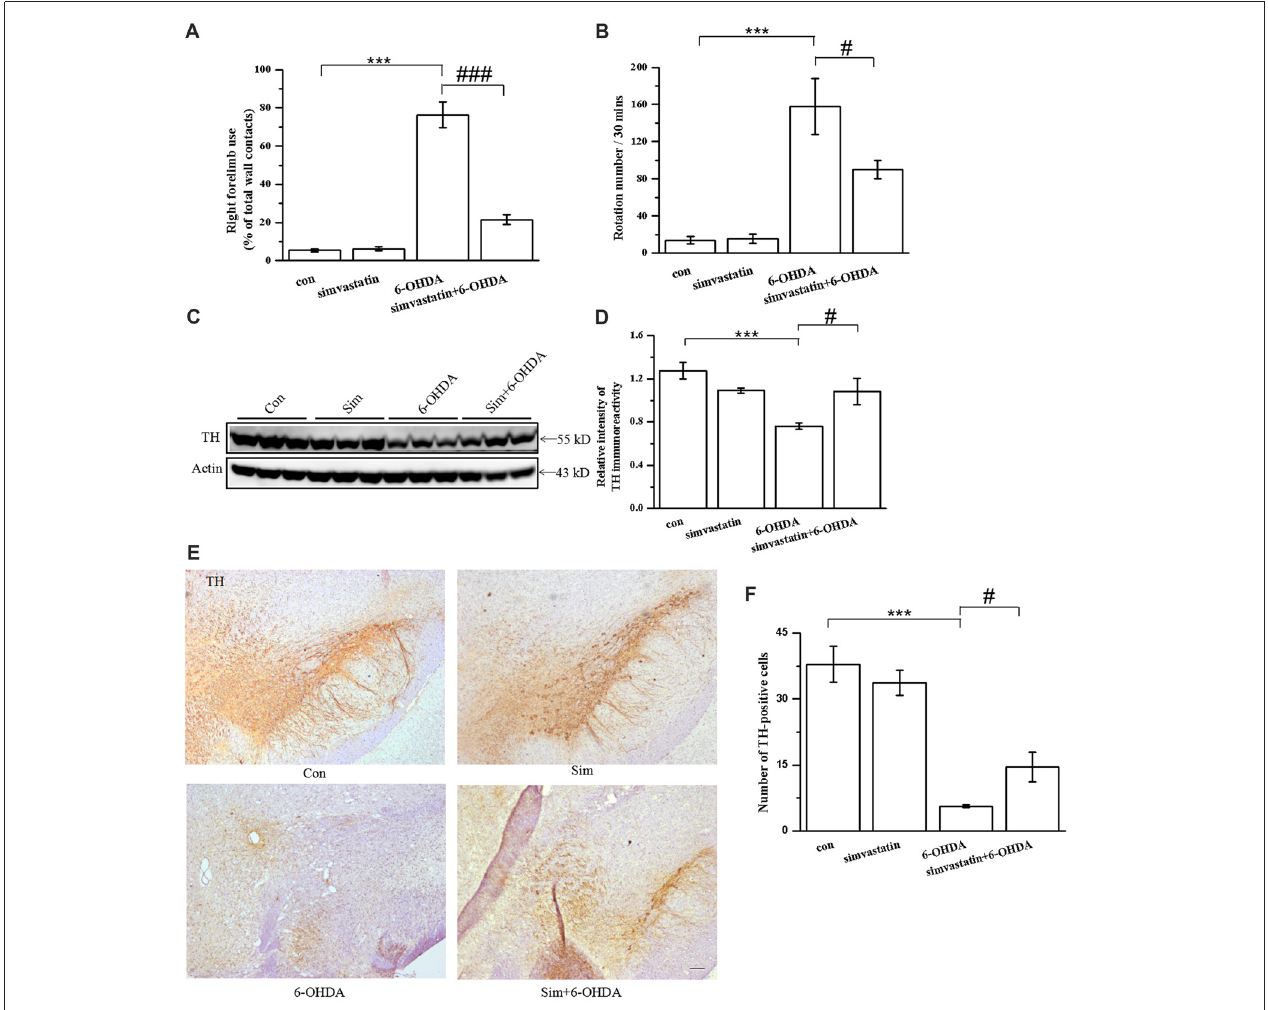
FIGURE 6 | Simvastatin improved behavior performance and dopaminergic neuronal survival in the unilaterally 6-OHDA-lesioned mouse model of parkinson disease (PD). (A) Cylinder test was performed 2 weeks after 10 µ g 6-OHDA stereotaxic injection of the substantia nigra pars compacta (SNc). A total of 20 contacts with the right or left forepaw on the wall of the cylinder were recorded; use of the right forelimb was expressed as a percentage of the total number of supporting wall contacts. Data were obtained from at least seven independent experiments. (B) Apomorphine-induced rotation 2 weeks after 6-OHDA stereotaxic injection was shown as the number of turns within 30 min. Data were obtained from at least five independent experiments. (C) Midbrain tissues were homogenized with radioimmunoprecipitation assay (RIPA) buffer. The supernatant contained the total protein after centrifugation; tyrosine hydroxylase (TH) expression was detected by western blot. (D) Relative quantitative analysis of TH expression. (E) Brain sections were prepared, incubated with TH antibody and HRP-conjugated secondary antibody, and visualized with 3,3-diaminobenzidine (DAB). (F) Relative quantitative analysis of TH-positive cells (dopaminergic neurons). TH-positive cells were counted using an IPP 6.0 system. Scale bar, 100 µ m. Data were obtained from at least three independent experiments. Statistical analysis by Dunnett’s T3 or LSD post hoc test based on ANOVA; data expressed as mean ± SEM. ∗∗∗ P < 0.001, # P < 0.05, ### P <